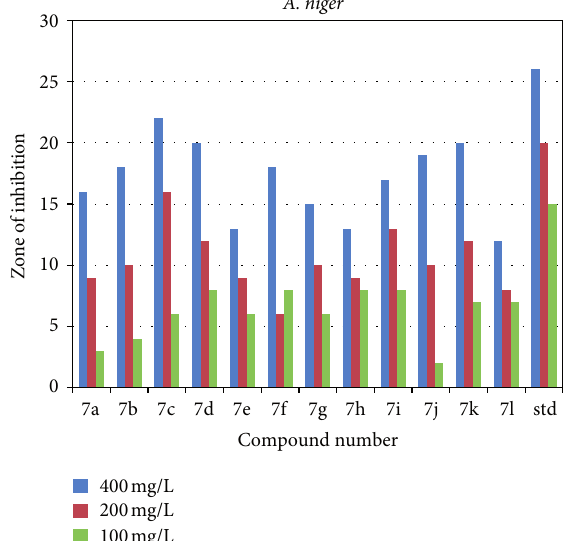
F 3: Antifungal activity against A. niger .